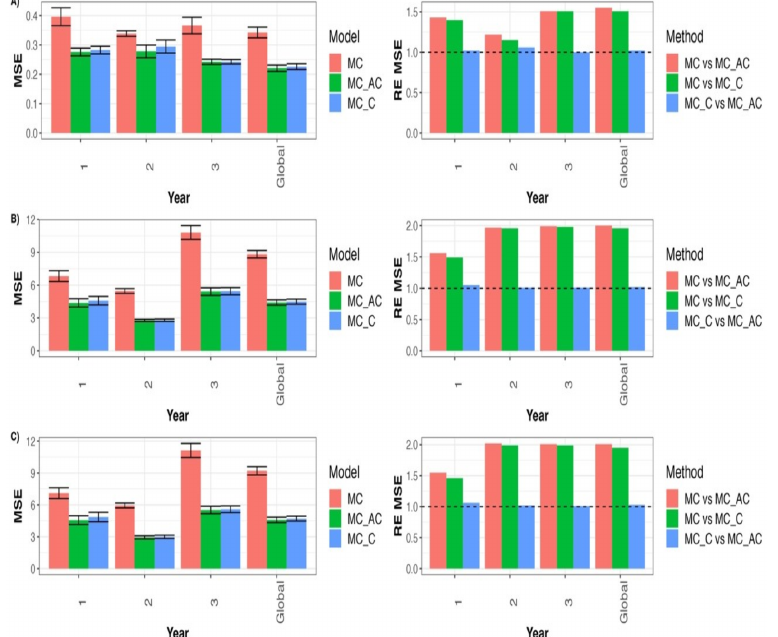
Figure A1. Prediction performance in terms of mean square error (MSE) for models MC, MC_C, and MC_AC, for each trait in each environment and across environments (Global) under untested lines in tested environments cross-validation strategy. The relative efficiencies (RE_MSE) were computed to compare models MC_C to MC_AC, MC to MC_C, and MC to MC_AC. ( A ) for GY trait, ( B ) for DTF trait, and ( C ) for DTH